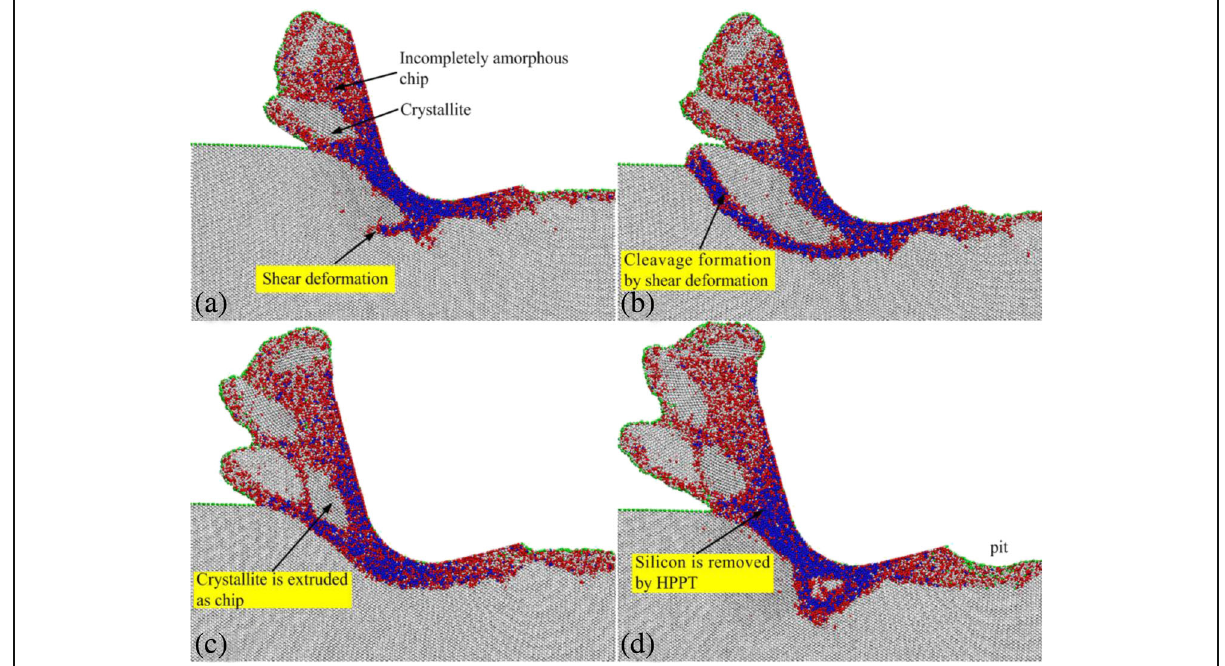
Fig. 8 Sectional views on the (110)[00 – 1] direction at cutting distances of a 42 nm, b 46 nm, c 52 nm, and d 64